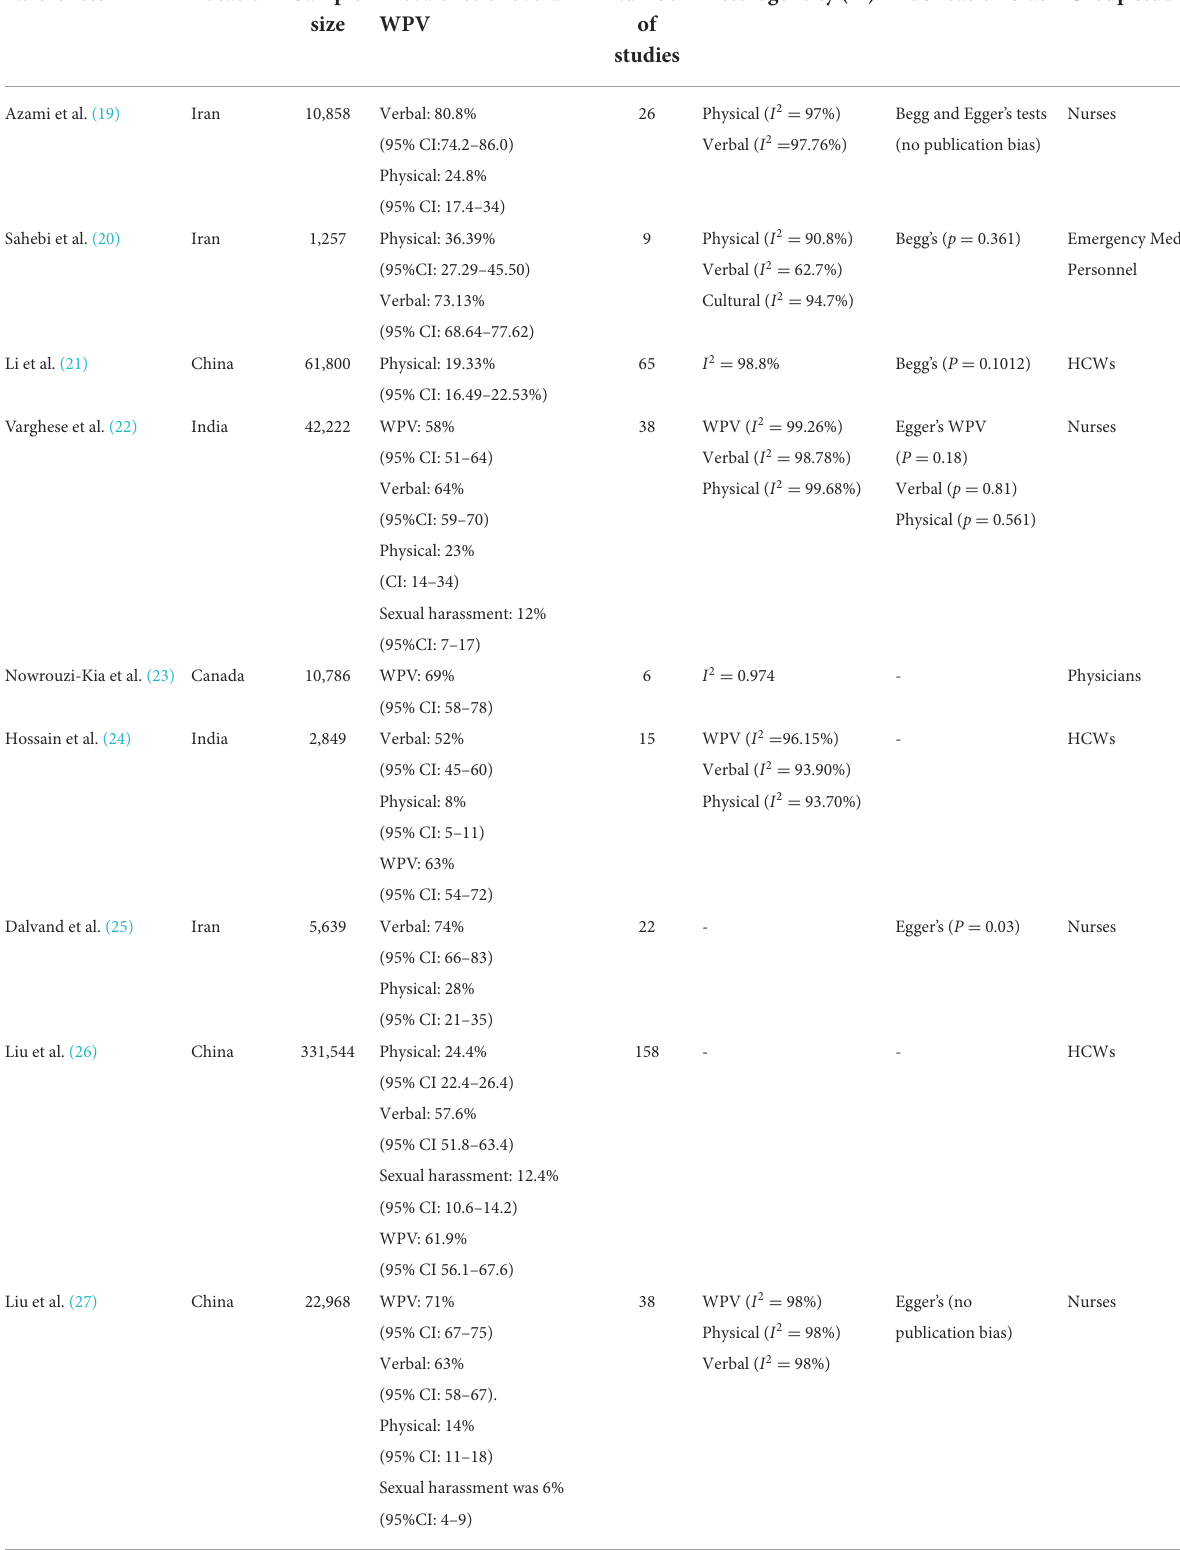
TABLE 2 The characteristic of studies included in the umbrella review and